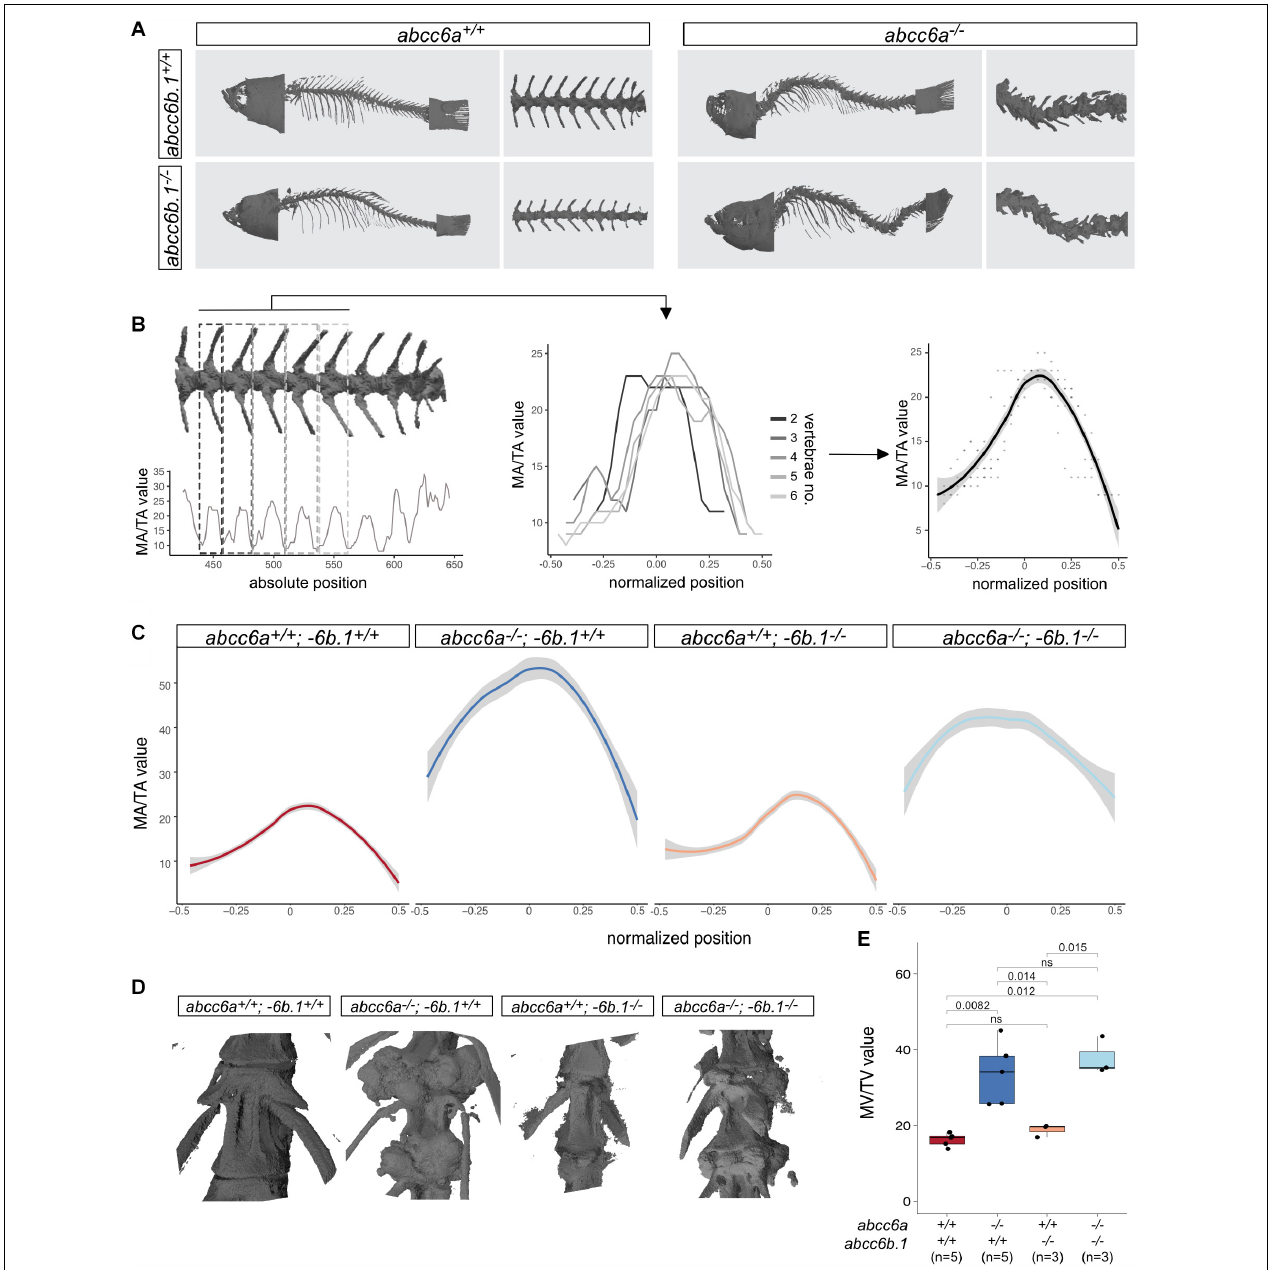
FIGURE 3 | Effects of Abcc6-impairment of skeletal development and life-span. (A) Micro-CT pictures of whole fish and partial vertebral column with indicated genotypes. Abcc6a mutants (regardless of the abcc6b.1 genotype) show easily observable, gross skeletal deformities. (B) A graphical explanation of the method used to calculate normalized MA/TA plots for each genotype. Briefly, MA/TA values calculated for vertebraes 2–6 were averaged to create the normalized plots. (C) Normalized plots of MA/TA values for the indicated genotypes. The results also indicate an increase in the mineralization of the vertebrae of abcc6a − / − fish, while mutations in abcc6b. 1 do not seem to affect this process. (D) 3D reconstruction micro-CT images of vertebrae in fish with the indicated genotypes. (E) MV/TV measurements for different genotypes. These results also demonstrate the effect of Abcc6a deficiency of the mineralization of skeletal vertebrae. Abcc6b.1 does not appear to be involved in the same process. (Significance levels calculated with t -test, ns = not